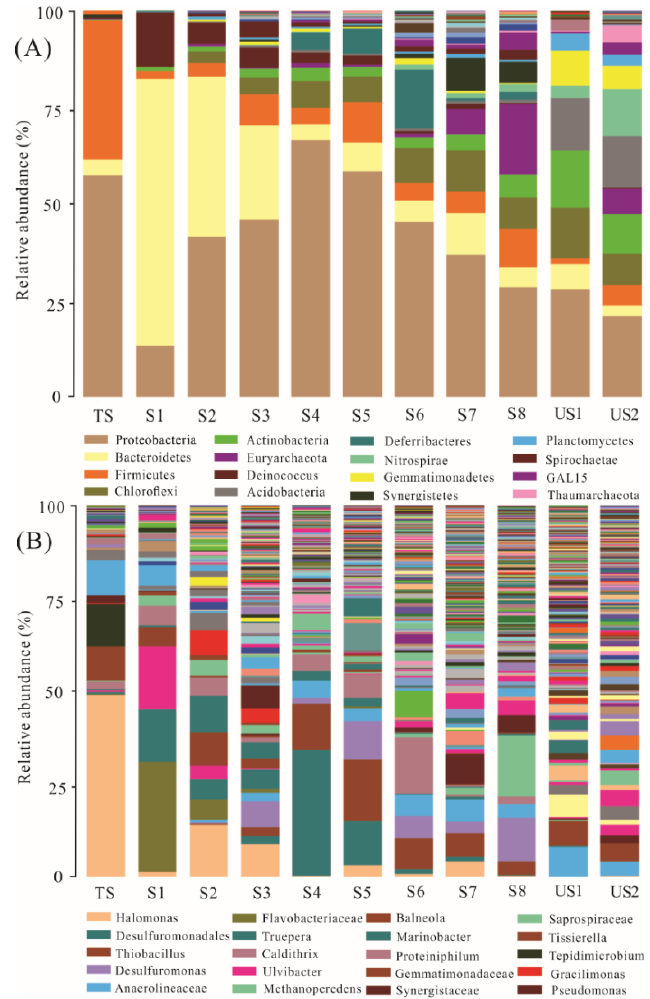
Figure 5. Relative abundances of bacterial taxa recovered from each sample. (A) phylum level; (B): genus level.